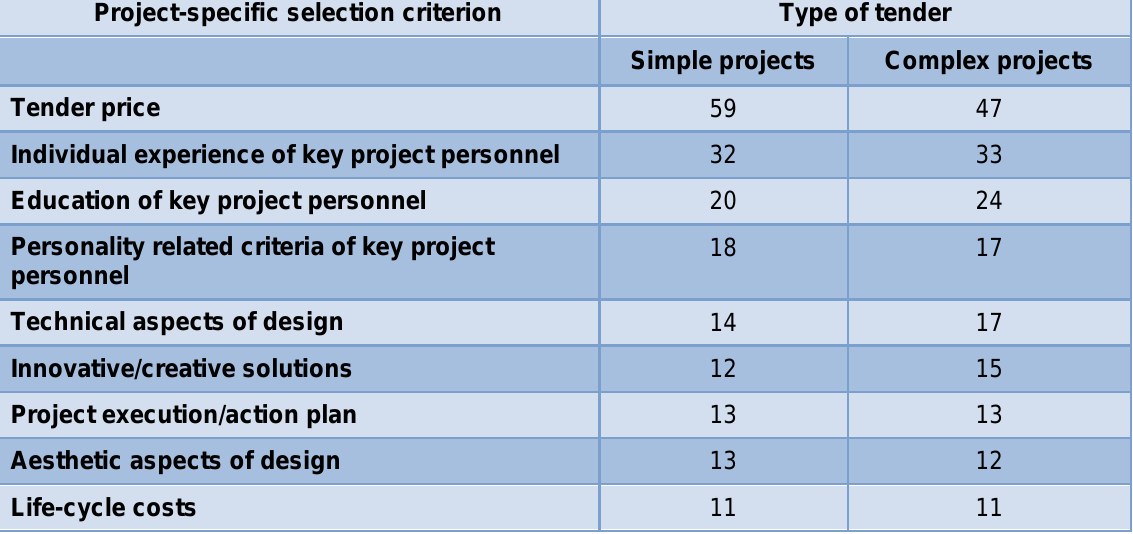
Table 2 Municipalities that use project-specific selection criteria (percentage of all